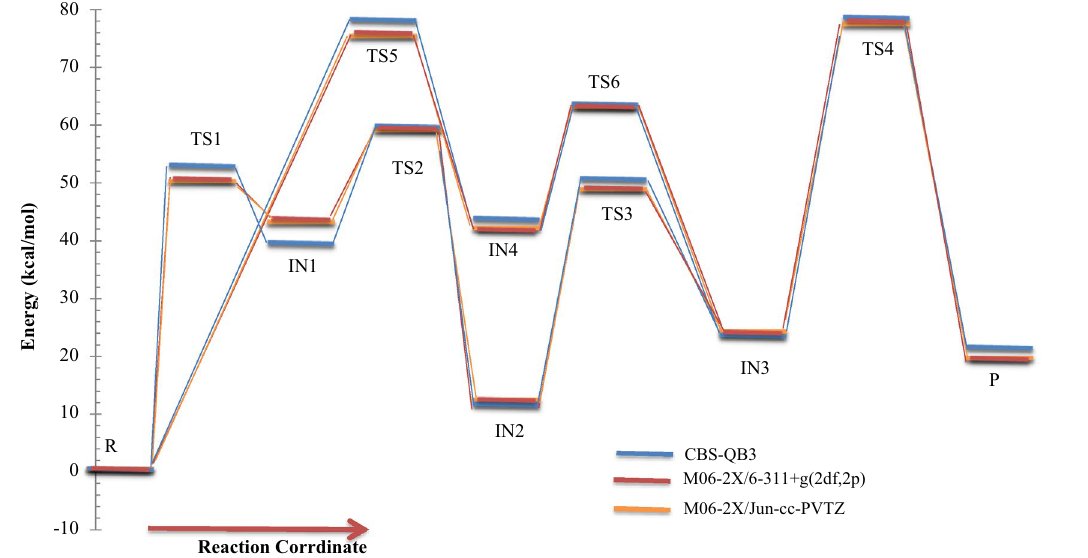
Figure 5. Energy diagram for 3-hydroxyfuran-2(5H)-one unimolecular reaction computed at the CBS-QB3, M06-2X/Jun-cc-pVTZ, and M06-2X/6-311+g(2df,2p) levels.